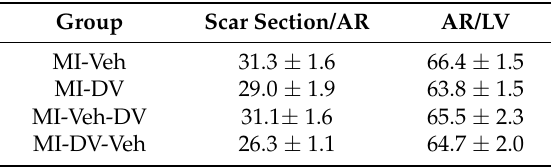
Table 1. Scar section and area at risk